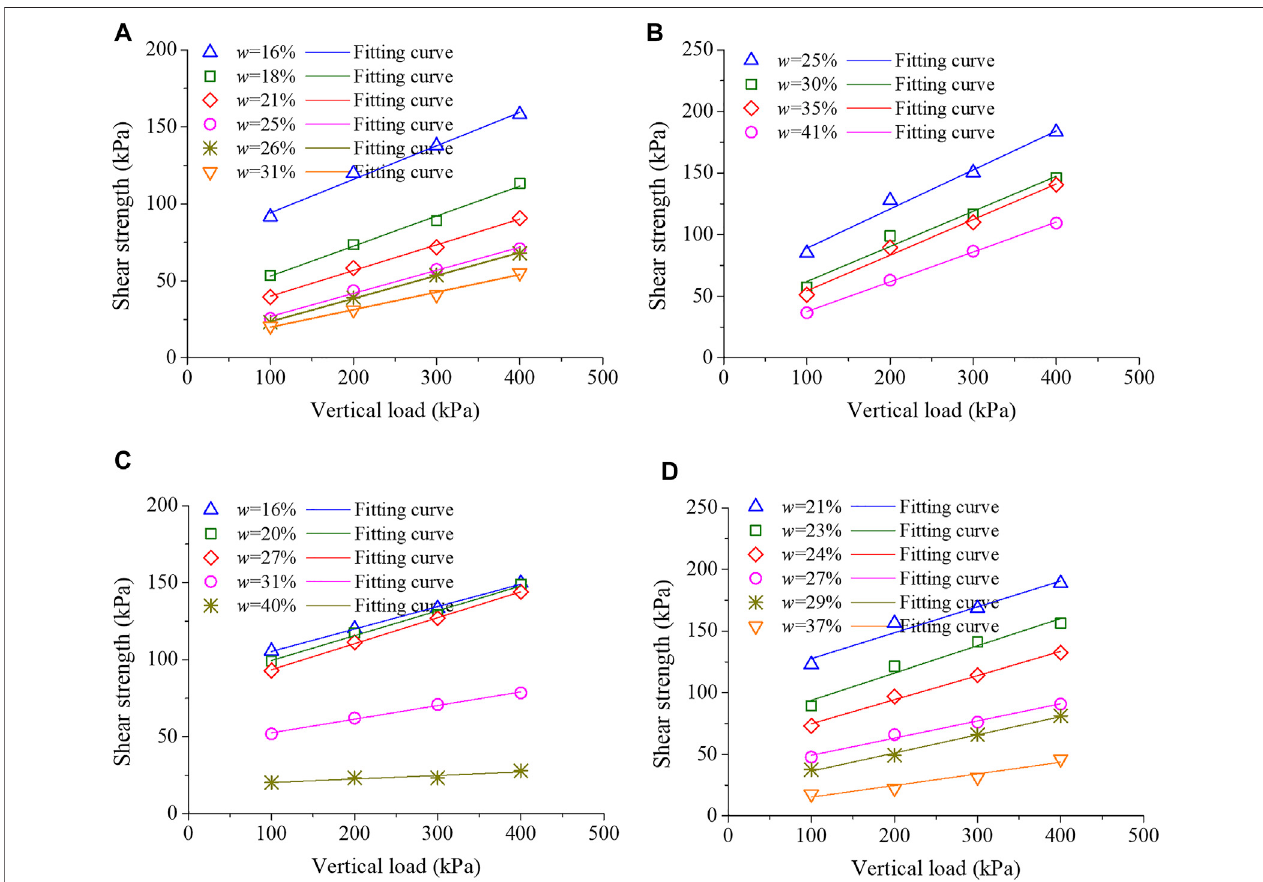
FIGURE 4 | Relationships between shear strength and water content for (A) WSC samples; (B) GCS samples; (C) RC-I samples and (D) RC-II samples.